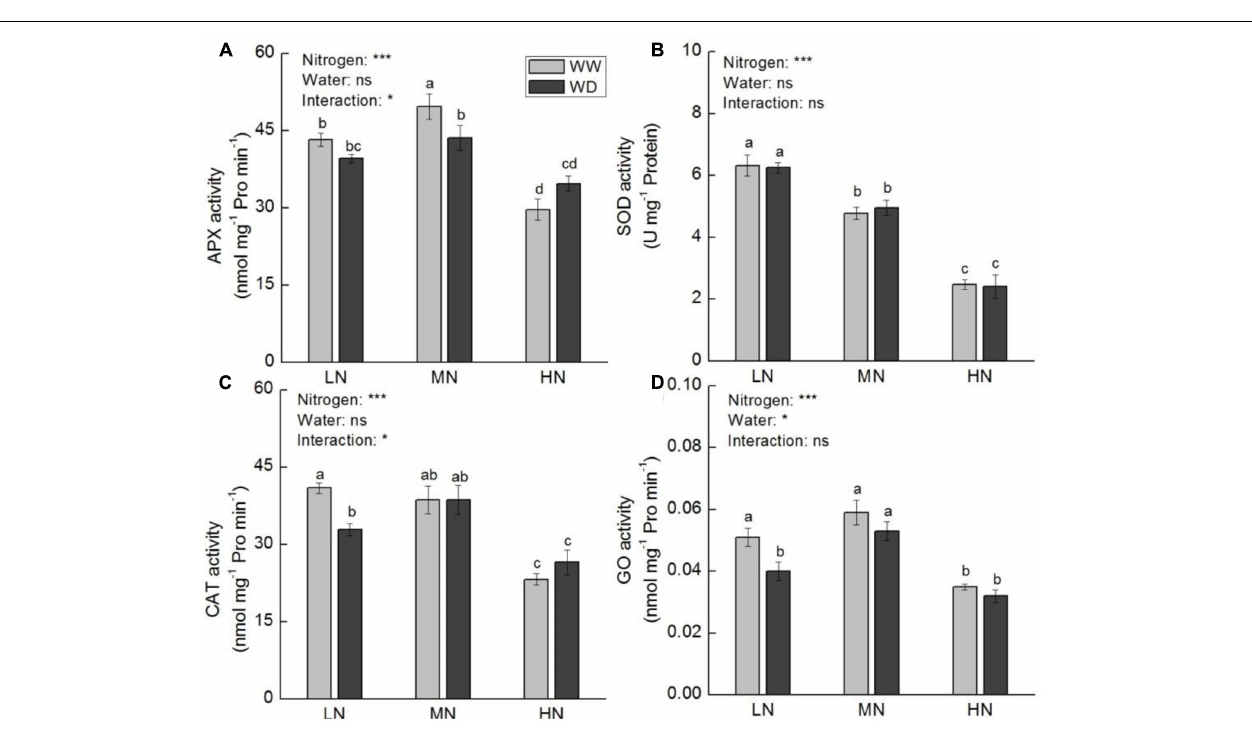
FIGURE 9 | Comparison in activities of ascorbate peroxidase (APX, A ), superoxide dismutase (SOD, B ), catalase (CAT, C ), and glycolate oxidase (GO, D ) in rice plants grown udner different nitrogen and water conditions. Data refers to mean ± SE ( n = 4). P -values of the two-way ANOVAs of nitrogen, water, and their interaction are indicated: ns, not significant; ∗ P < 0.05; ∗∗ P < 0.01; and ∗∗∗ P < 0.001. Bars with the same letter are not significantly different by LSD test. WD, water deficit; WW,